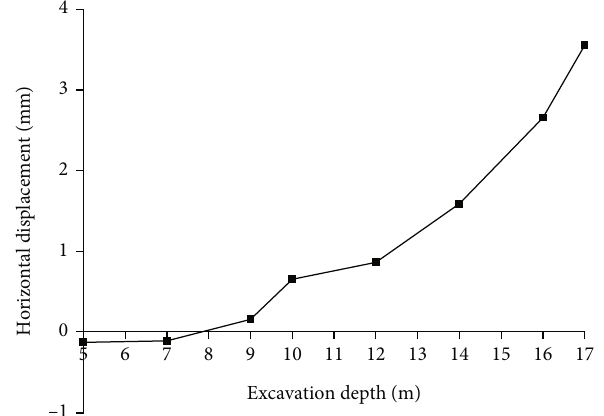
Figure 8: Simulation curve of horizontal displacement of supporting pile